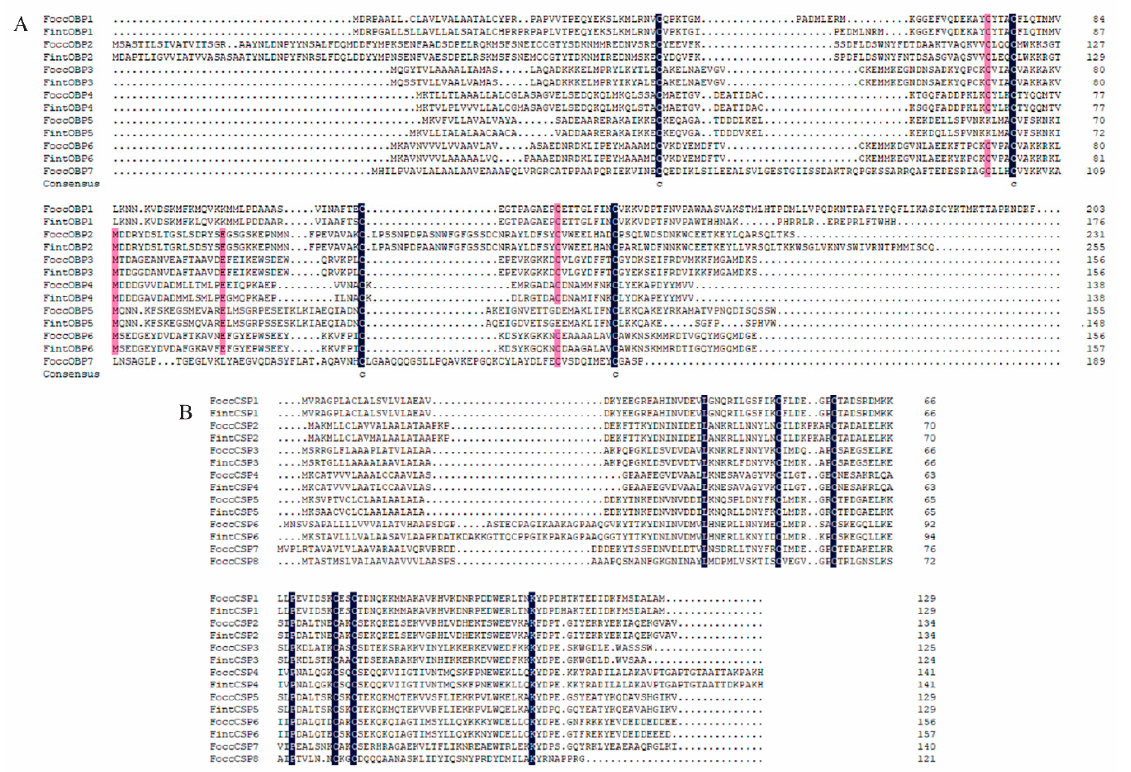
Figure 3. OBP ( A ) and CSP ( B ) amino acid sequence alignment in Frankliniella occidentalis and Frank- liniella intonsa. Frankliniella intonsa